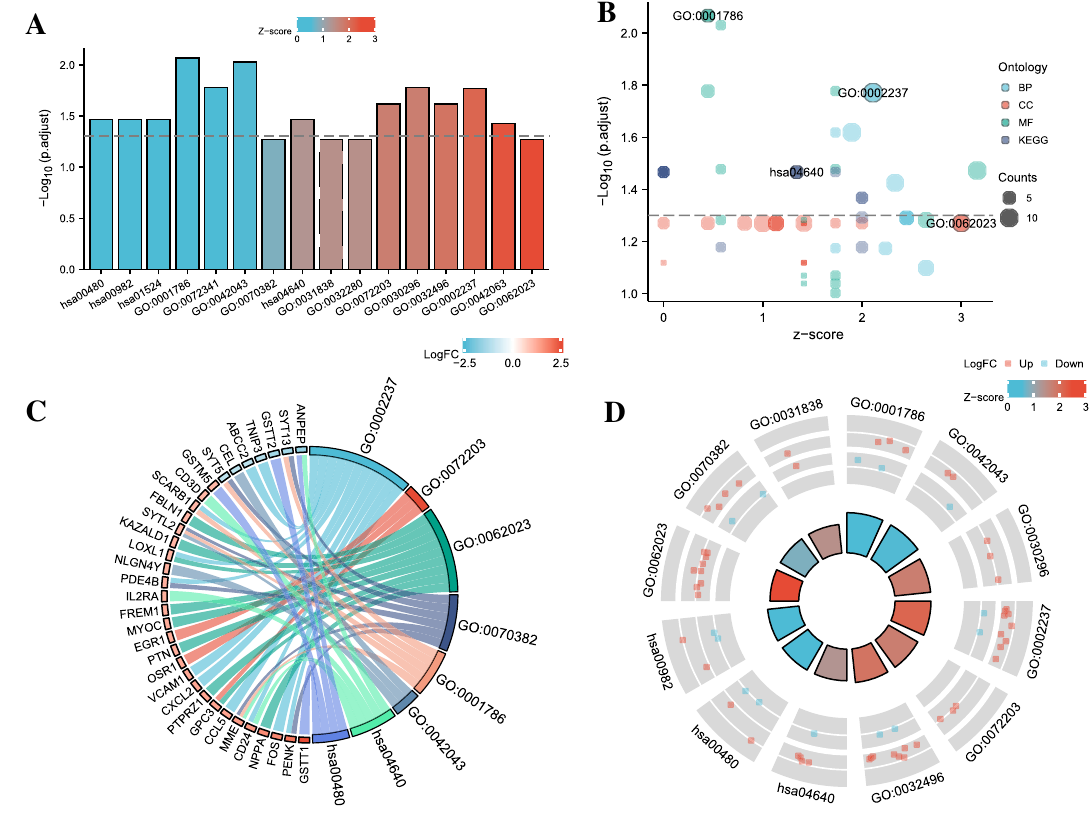
Figure 3. Enrichment plots by GO and KEGG. (( A ) Bar graph, ( B ) Bubble plot, ( C ) chord diagram, ( D ) loop graph. BP: Biological Process; CC: Cellular Component; MF: Molecular Function).